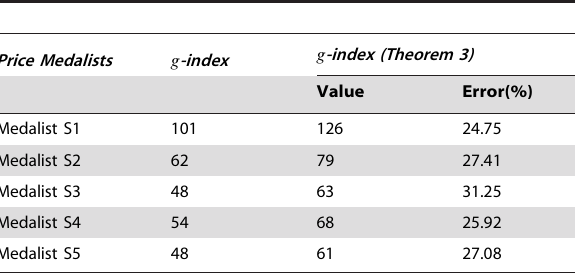
Table 4. Errors in the g -index using Theorem 3 for the given set of Price Medalists.